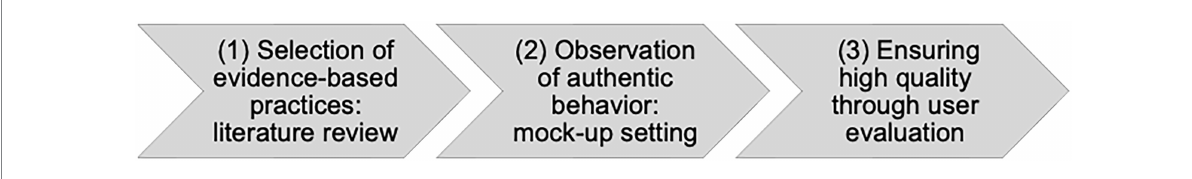
FIGURE 1 Three-step design approach for evidence-based video case